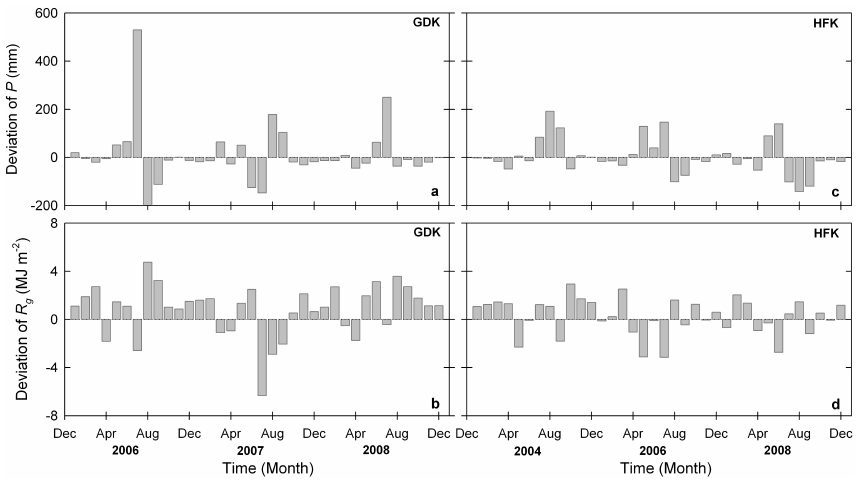
Fig. 3. Deviation of cumulative monthly precipitation ( P ) from the climate normal sum and deviation of mean monthly solar radiation ( R g ) from the climate normal mean at the GDK and HFK sites. The climate normal was calculated using the data from 1971–2000. 1